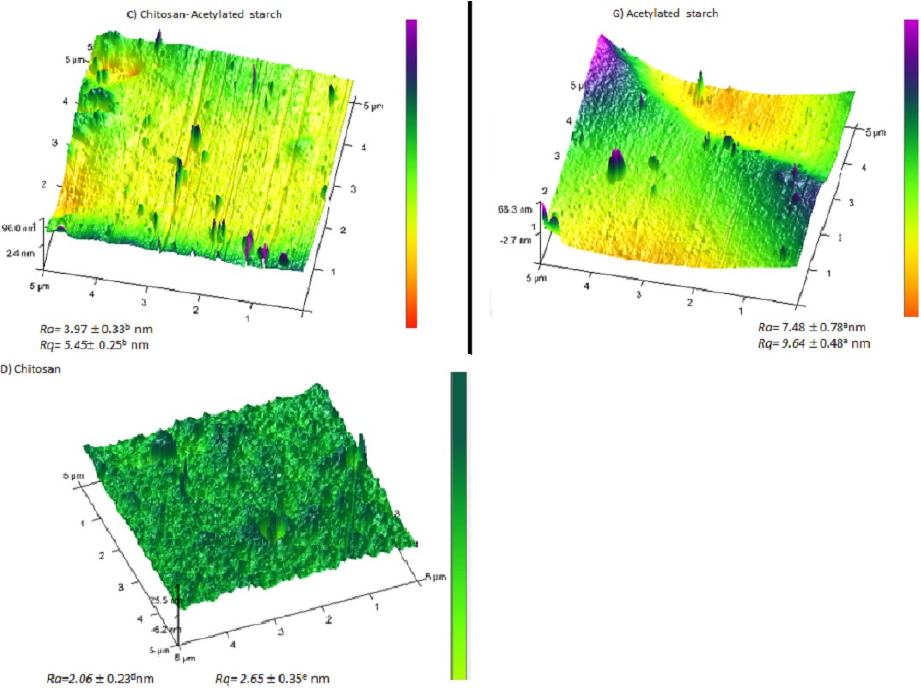
Figure 2. AFM Micrographs of edible films: ( A ) Chitosan–Waxy starch; ( B ) Chitosan–Oxidized starch; ( C ) Chitosan–Acetylated starch; ( D ) Chitosan; ( E ) Waxy starch; ( F ) Oxidized Starch; ( G ) Acetylated starch. Superscript letters a–e used next to reported values indicate that if the same letter appears in the same parameter, the values compared are not significantly different ( p > 0.05).